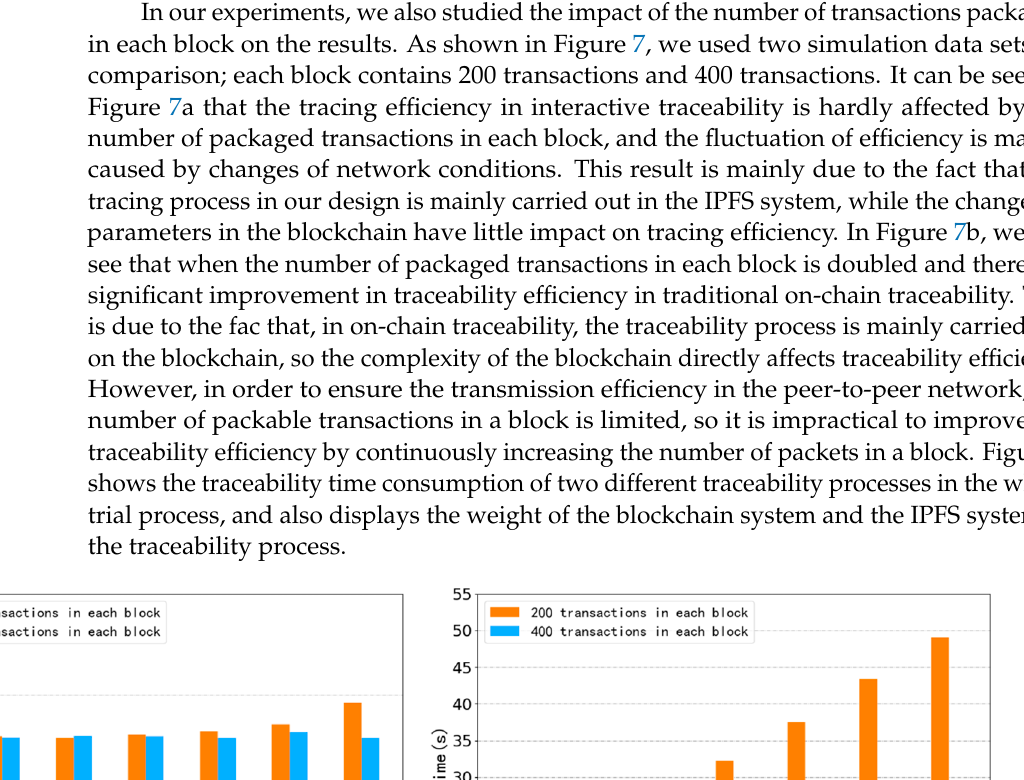
Figure 8. Comparison of traceability efficiency between two different traceability processes. Unlike in [14], it can be seen from Figure 8 that in the traditional on-chain tracing, the interaction time with IPFS is stable at about 4 s (mainly the time consumed when